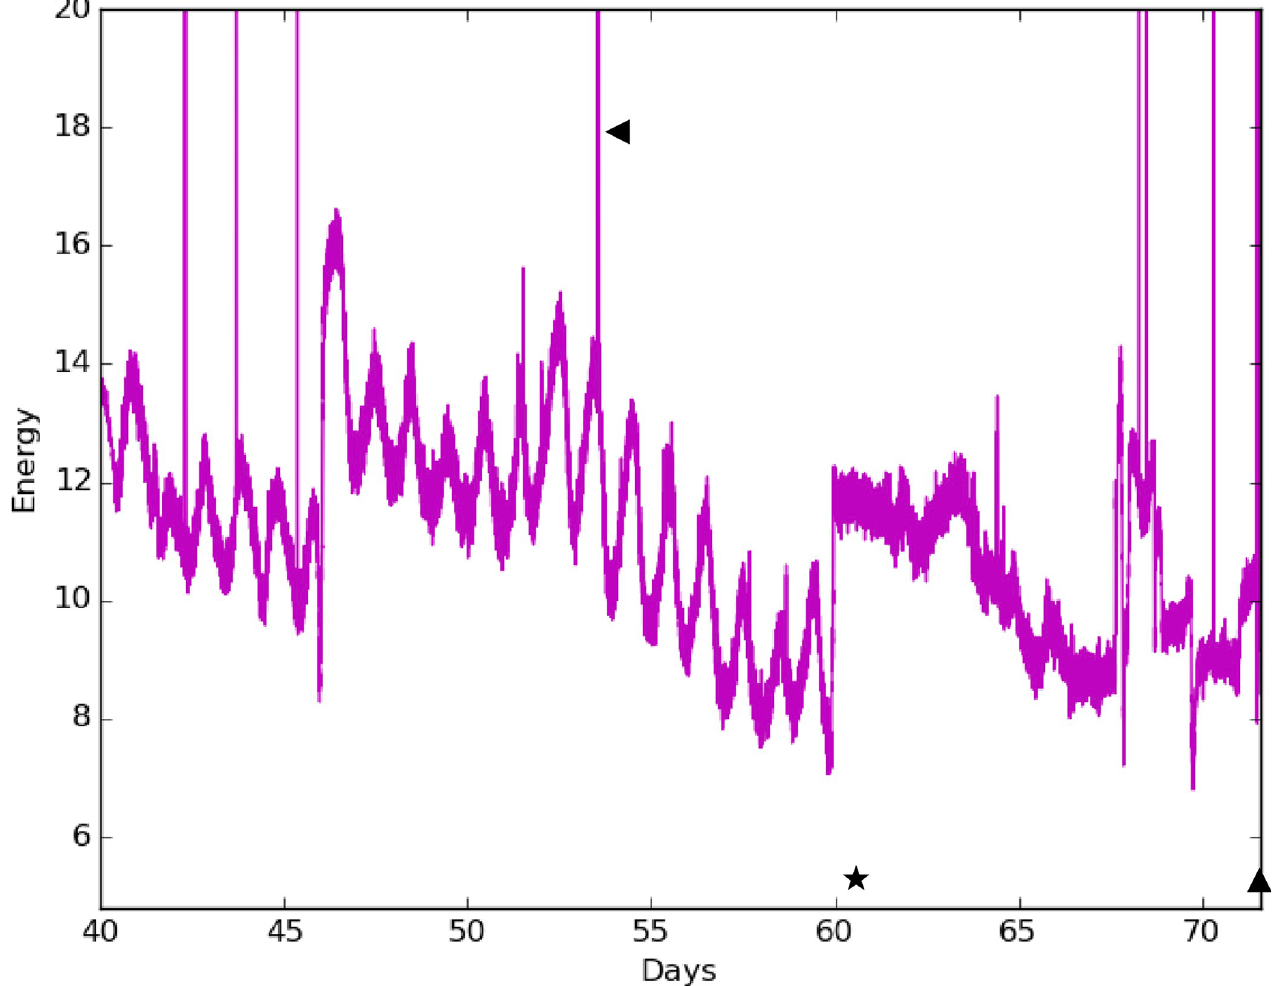
Fig 2. Energy plot exhibiting overwash and nest disturbance representative motion data. This infertile in-situ nest was located in an Off Road Vehicle area in Avon, NC (NH013; 2015). Multiple tidal overwash events were recorded at this nest site spanning Days 3–71. The key features are the undulating waveform and the sudden discontinuity in the average background signal. On Day 60, an Off Road Vehicle knocked over the corner sign on the nest enclosure (star), though the nest remained intact. Hatching activity was never detected and the nest was excavated on Day 71 to confirm an infertile nest with 72 undeveloped eggs. Spikes in the data are representative of nest disturbances, such as NPS nest checks or ghost crab predation events (triangles).